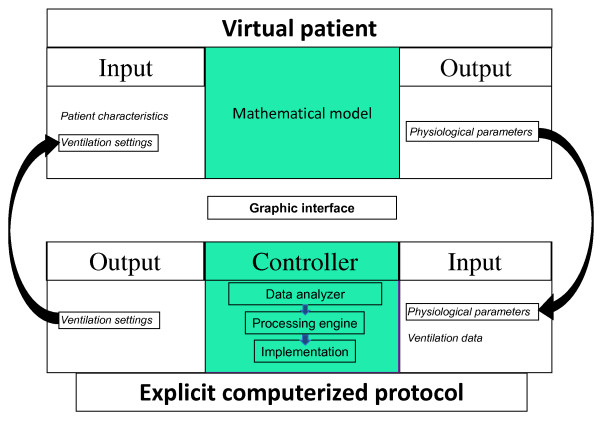
The five components of a platform for development of an explicit computerized protocol (input data, controller, output data, graphic interface, virtual patient). The explicit computerized platform collects the data from the patient (SpO2, ETPCO2, ventilation data...) and processes the data to determine new ventilator settings in open- or closed-loop (output data). The virtual patient simulates the breathing pattern and the resulting blood gases for a mechanically ventilated patient with predefined characteristics (age, body weight, lung compliance, cardiac output, ventilator settings...). This virtual patient helps to test a large panel of clinical situations to validate the rules implemented and to detect any bugs.